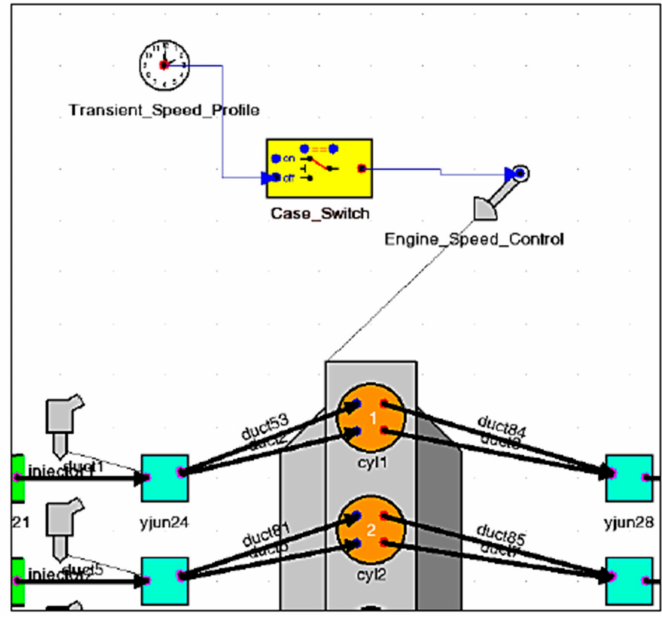
Figure 23. Transient WAVE simulation component setup. Table 7. Number of cycles required to complete a 3-s transient simulation for each engine